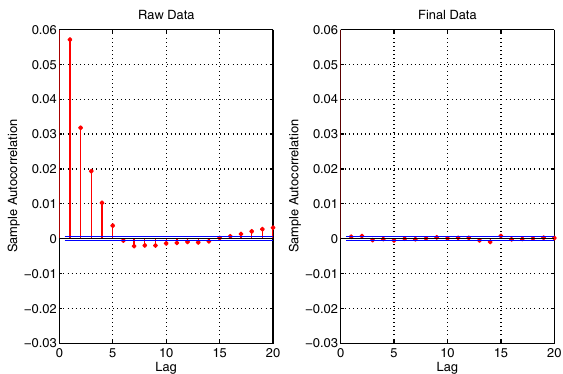
FIG. 8. The autocorrelation function of the raw data and the final data. The x axis is the lag j between the sampled data X i and X y axis is the autocorrelation R ð j Þ defined in i þ j , while the Eq. (7). Data sizes of both the raw data and the final data are on the order of 10 7 . The autocorrelation of the final data is significantly smaller than the raw data in absolute value. Because of finite-key-size effects, the autocorrelation cannot be zero even for perfectly random